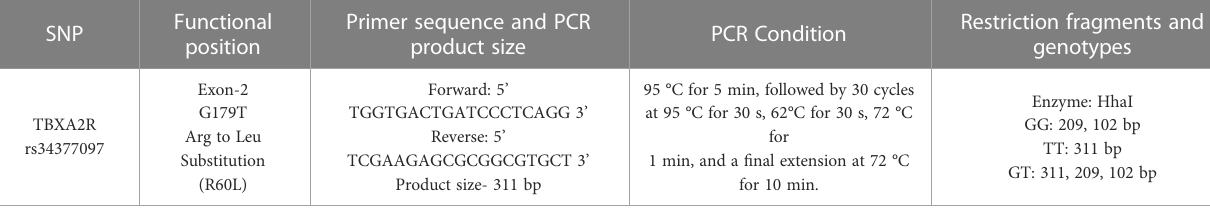
The association of FEV1/FVC ratio with atopy is depicted in Figure 3. Signi fi cant negative correlation was found between FEV1/ FVC ratio and intensity of SPT reactions which is denoted by wheel diameter in all age groups and sexes (P<0.0001).The association of FEV1/FVC ratio with habitat of both patients and controls is depicted in